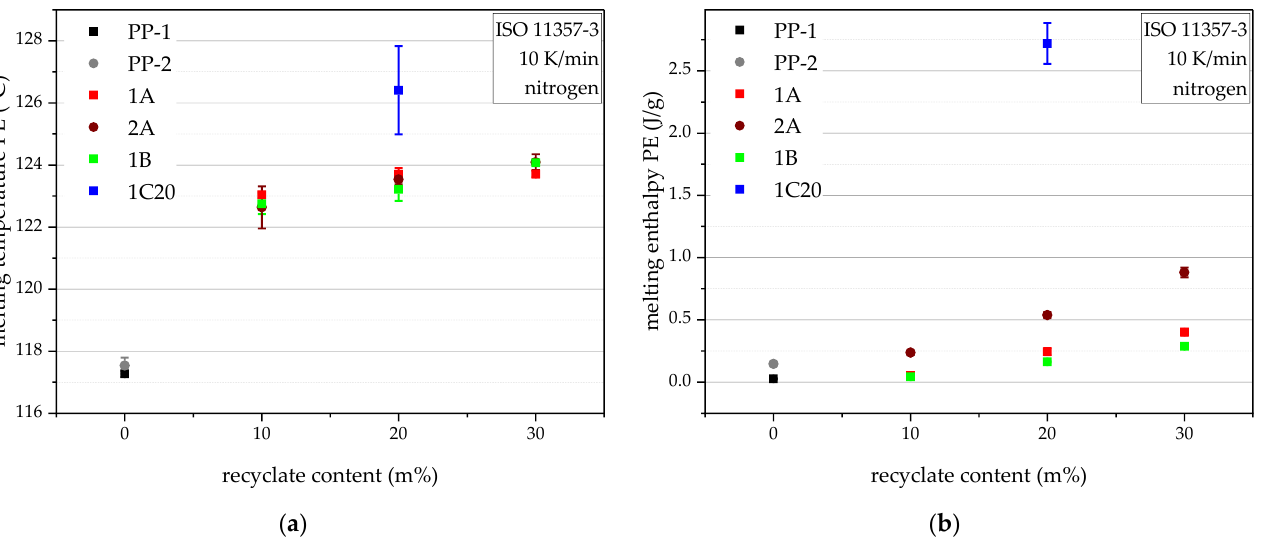
Figure 6. DSC results of the virgin blending partners and all compounds in terms of PE melting tem- peratures ( a ) and PE melting enthalpies ( b ). The vertical bars show the sample standard deviations.